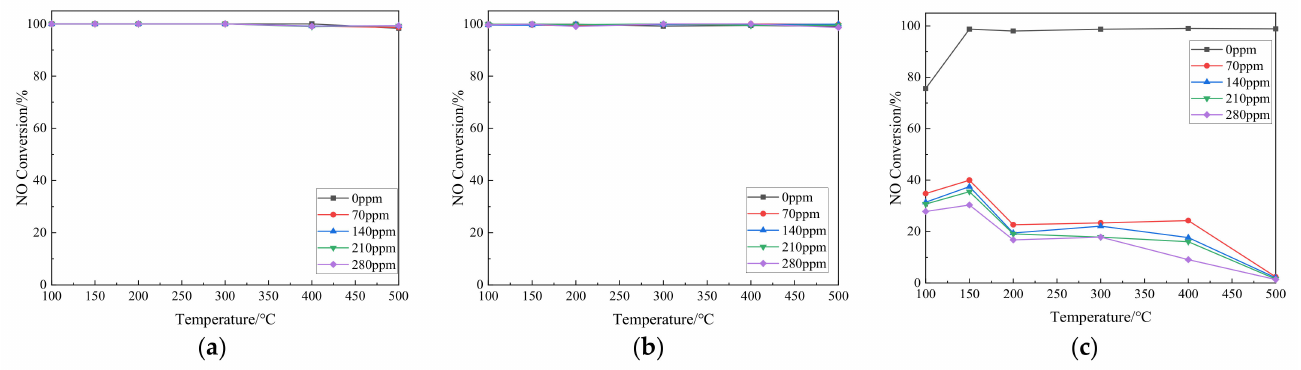
Figure 10. The effect of SO 2 concentration on NO conversion: ( a ) Fe 0.8 Cu 0.2 /RHA; ( b ) Fe 0.67 Cu 0.33 /RHA; ( c ) Fe 0.5 Cu 0.5 /RHA.